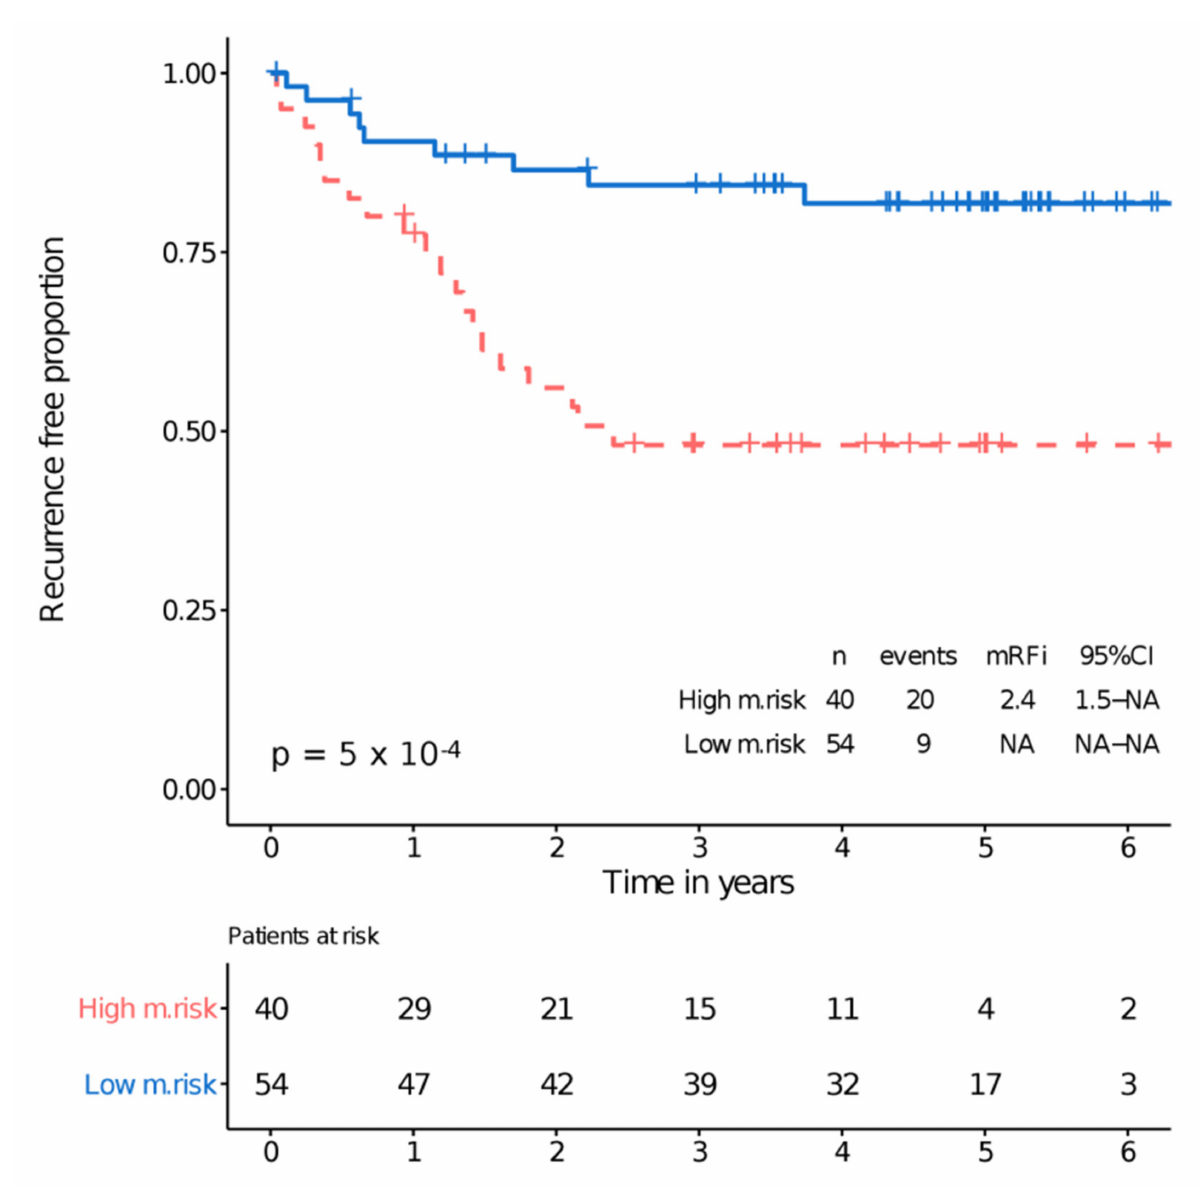
Figure 5. RFI by metabolomic